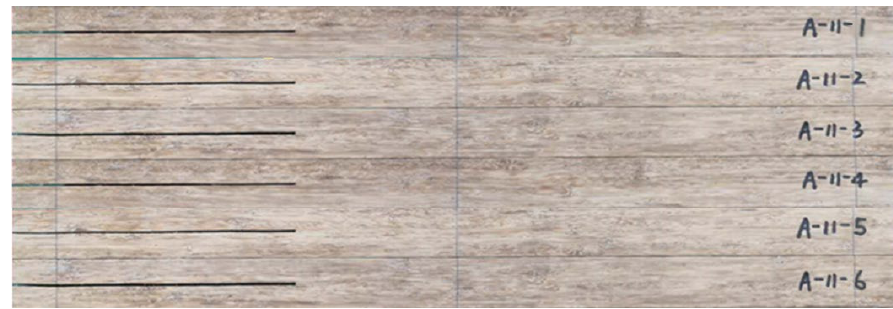
Figure 1. Engineered bamboo specimens.